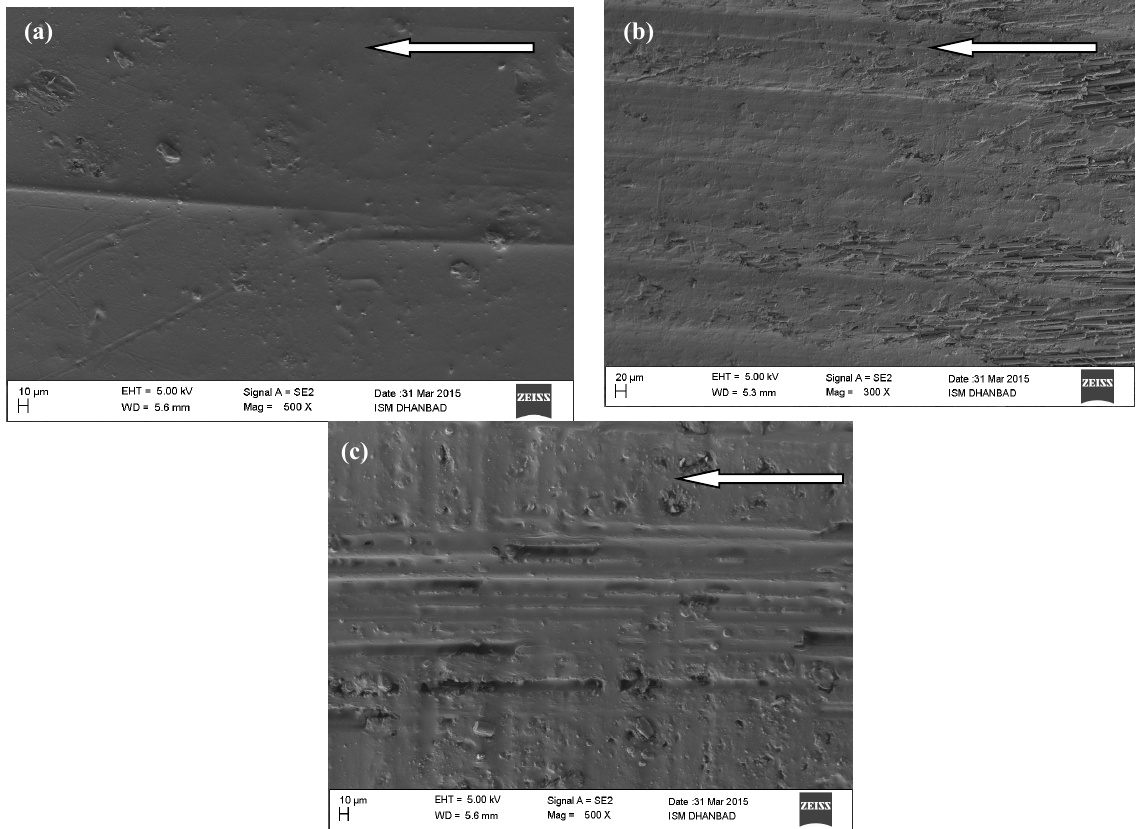
Figure 8. CNT filled GFRP composite worn out surface for oil-lubricated sliding at 3.14 m/s and for ( a ) 40 N, ( b ) 80 N and ( c ) 120 N.